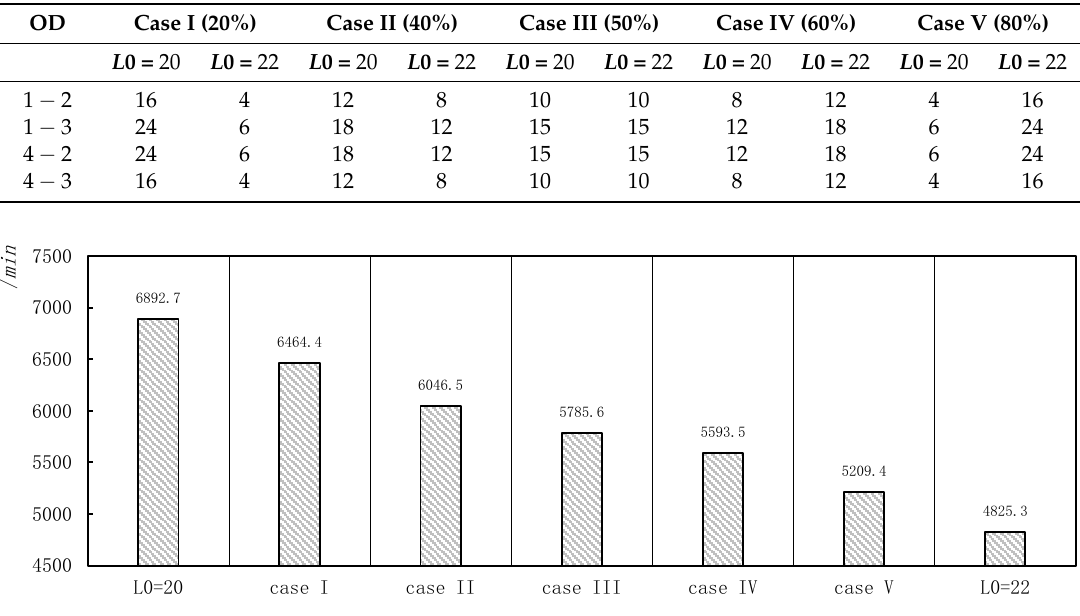
Table 13. Numbers of agents with various initial charge levels for one OD pair.